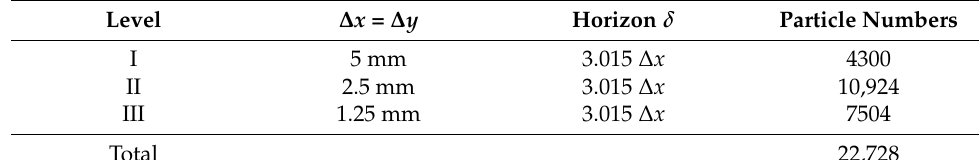
Figure 14. L-shaped plate geometry and three-level discretization. Table 1. Values of peridynamics parameters for the DH-PD